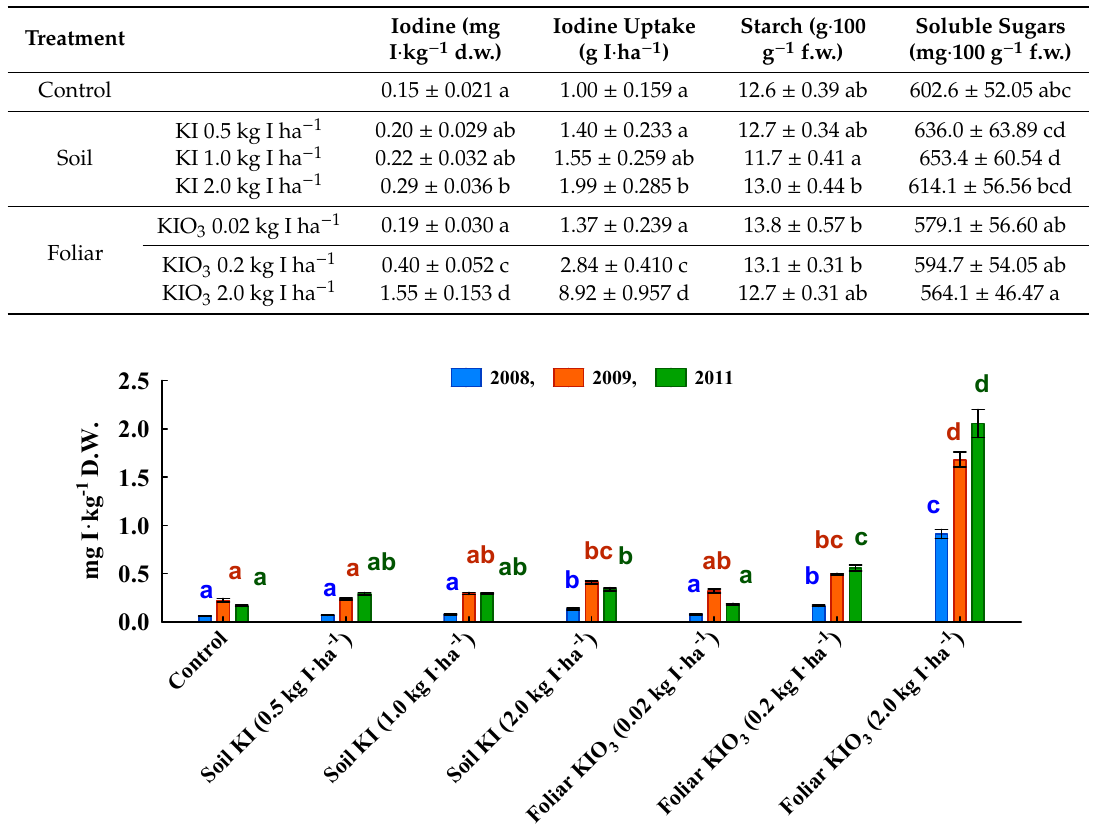
Figure 2. Iodine content in potato tubers in individual years the study; values followed by the same Figure 3. Iodine uptake by potato yield in individual years the study; values followed by the same letters letters within an individual year are not statistically di ff erent at p < 0.05, ( n = 4). within an individual year are not statistically different at p < 0.05, ( n = 4).